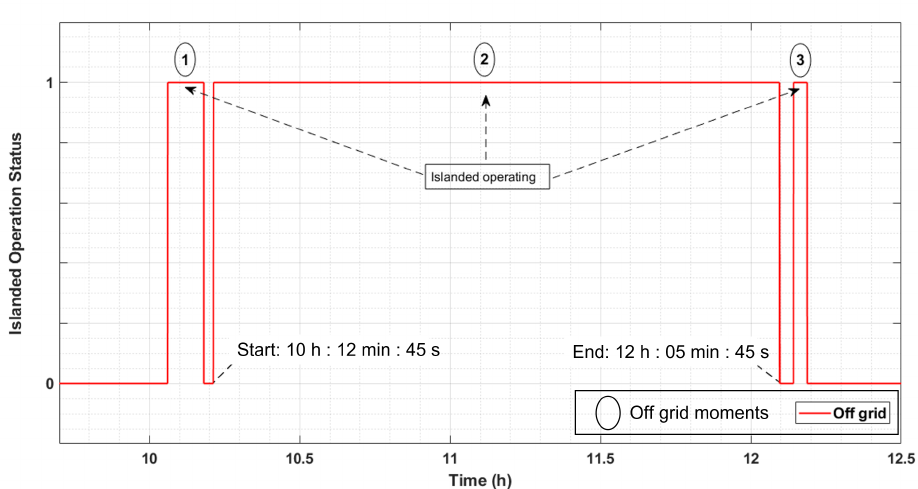
Figure 8. Microgrid islanded operation.